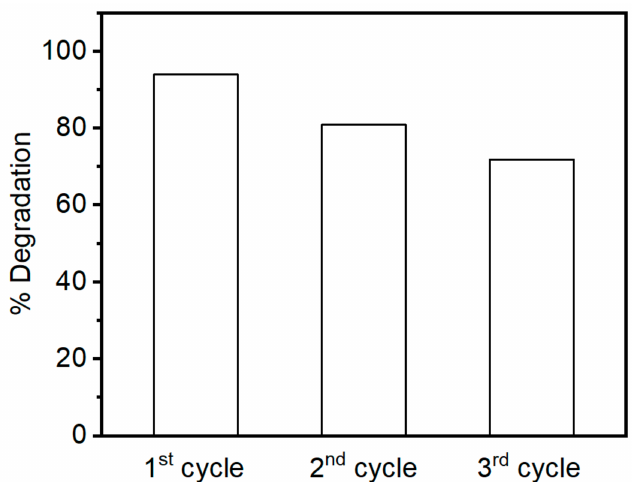
Figure 9. Reusability of Cu-Vo for the degradation of MB under natural solar